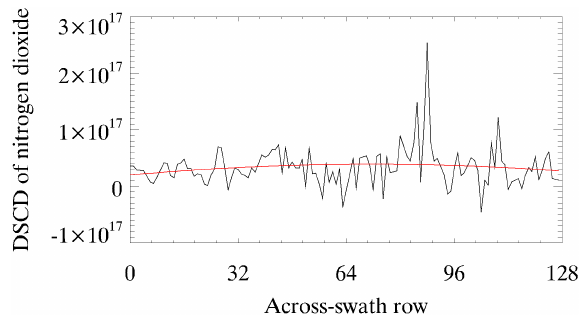
Figure 7. Destriping procedure on the data from the ANDI instru- ment. In black are mean dSCD measurements from each across- track pixel, averaged over the entire flight. In red are mean dSCDs after destriping has been